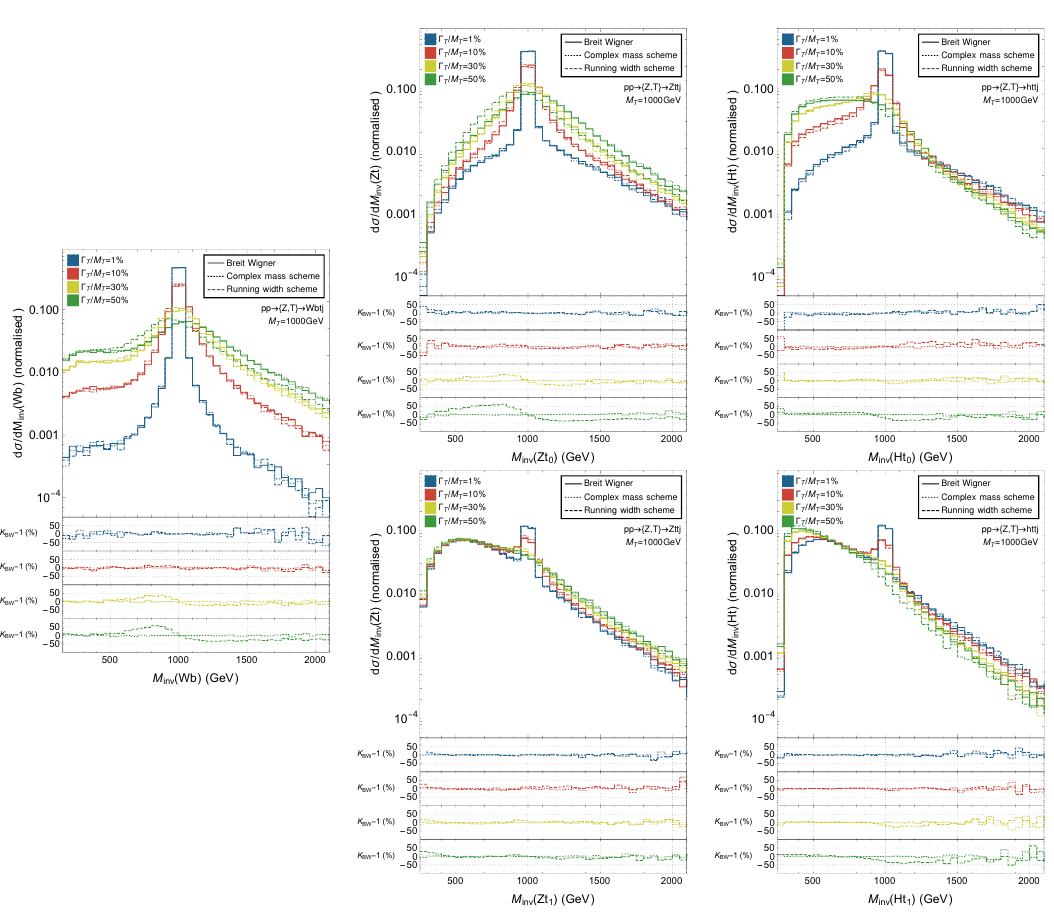
Figure 19 . Comparison between predictions obtained in different schemes when treating the VLQ width. We consider M = 1000 GeV and different observables and channels: the invariant-mass T spectrum of the Wb system for the pp → { Z, T } → Wbtj process (left), of the Zt system (with the leading top quark) for pp → { Z, T } → Zttj (centre top), of the Zt system (with the sub-leading top quark) for pp → { Z, T } → Zttj (centre bottom), of the ht system (with the leading top quark) for pp → { Z, T } → httj (right top) and of the ht system (with the sub-leading top quark) for pp → { Z, T } → httj (right